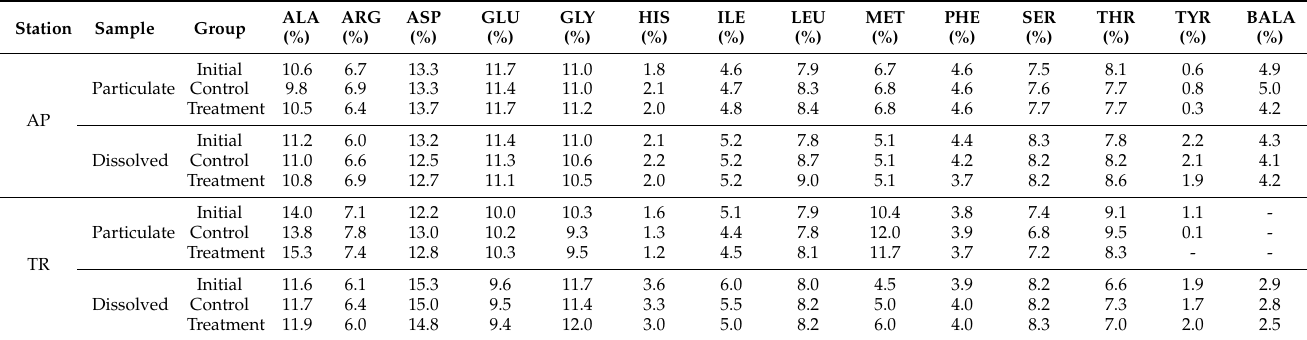
Table 2. Mol fraction of amino acids. Abbreviations: ALA: alanine; ARG: arginine; ASP: aspartic acid; GLU: glutamic acid; GLY: Glycine; HIS: histidine; ILE: isoleucine; LEU: leucine; MET: methionine; PHE: phenylalanine; SER: serine; THR: threonine; TYR: tyrosine; BALA: β -alanine; AP: coastal Avery Point site; TR: estuarine Thames River site. Initial denotes the field data; treatment denotes samples after two days of rolling; and control denotes samples incubated for two days without rolling. Each sample had triplicates.